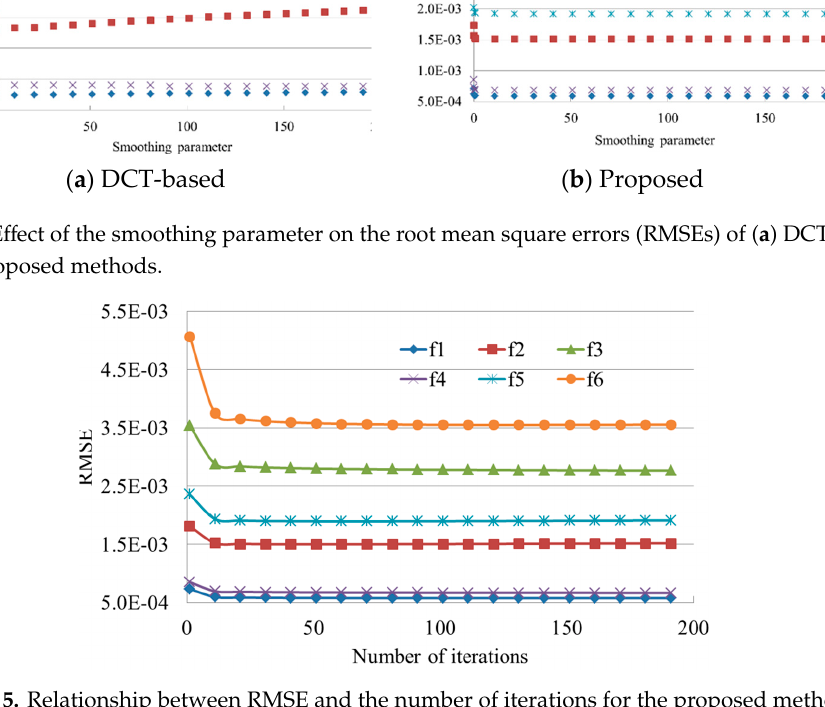
Figure 5. Relationship between RMSE and the number of iterations for the proposed method.